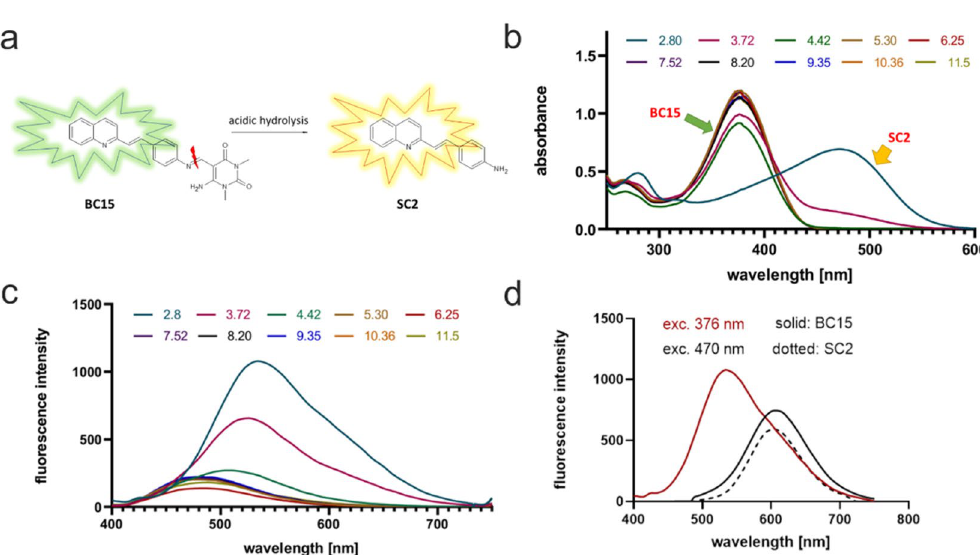
Figure 3. Pro-dye strategy for detecting low pH in lysosomes and endosomes. ( a ) Acid hydrolysis of the dye. ( b – d ), spectroscopic characteristics of the dyes. ( b ) Absorbance of the pro-dye BC15 and fluorophore SC2 . Below pH = 4, decomposition and the formation SC2 begins, which later gets protonated in pH below 3, thereby resulting in a more red-shifted absorbance. This second maxima of absorbance can be used for the excitation of the released dye solely as is presented in ( d ). ( c ) pH-dependent changes in fluorescence for the dye. During acidification, no changes were observed until pH 5.3 when the maxima shifted to the higher wavelengths. ( d ) Comparison of the BC15 and SC2 fluorescence. Excitation with 376 nm only emitted a green fluorescence while excitation with 470 resulted in an orange fluorescence only from the acidic